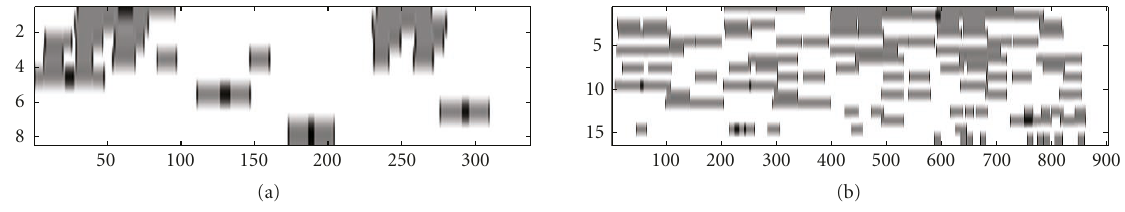
Figure 14: (a) Mendelssohn, “Wedding March,” op. 21-7, conducted by Tate. (b) Ravel, “Bolero,” conducted by Ozawa.